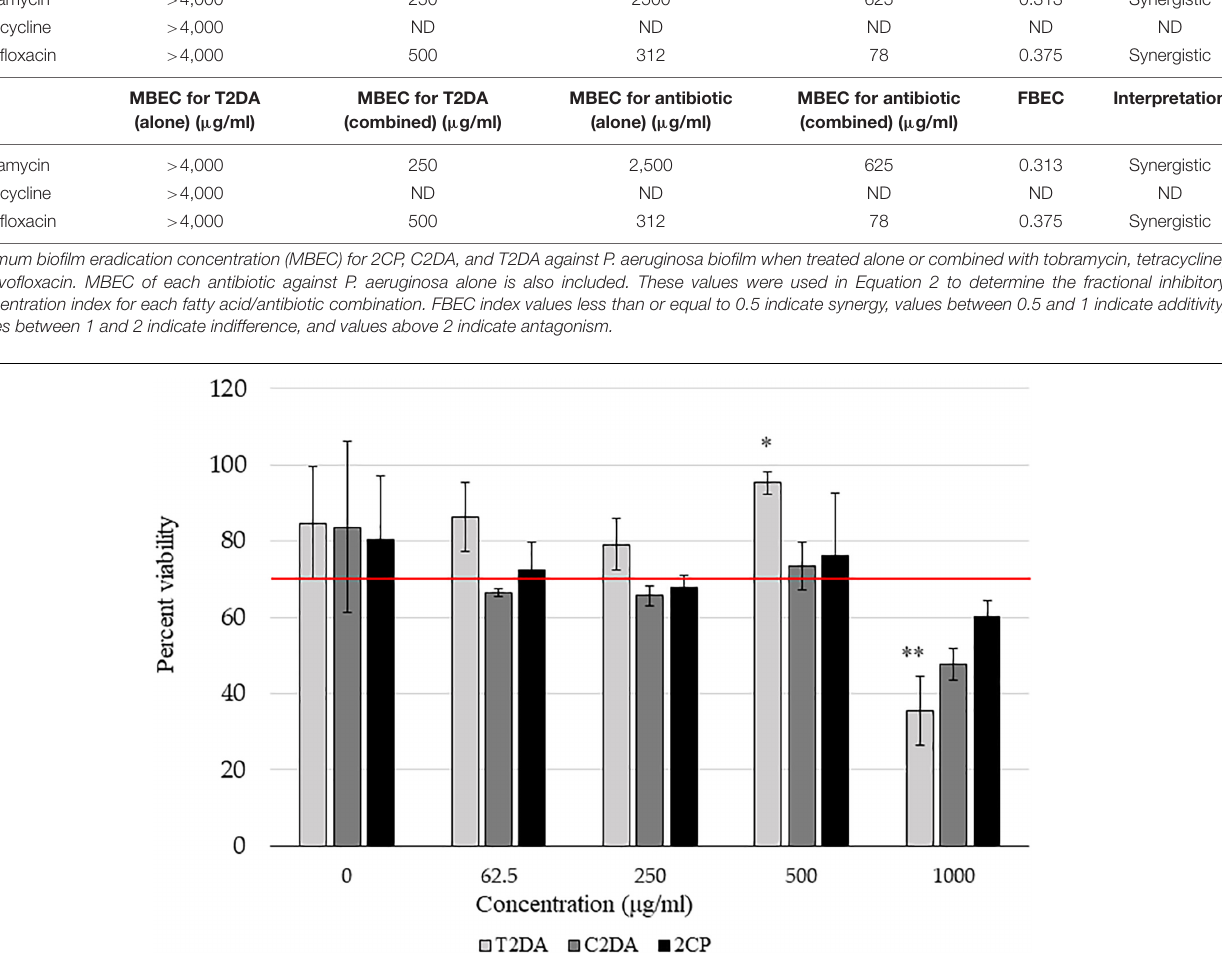
MBEC for antibiotic (alone) ( µ g/ml)